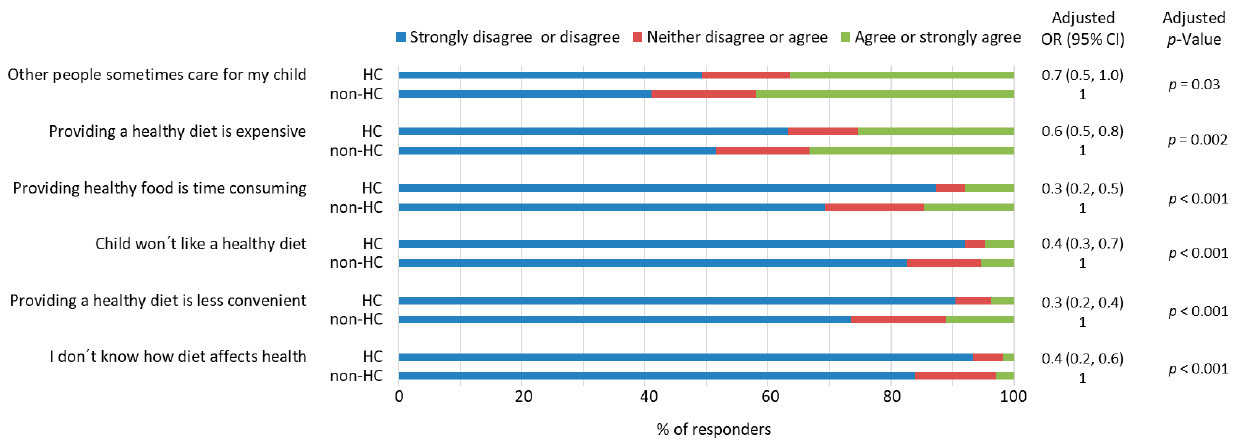
Figure 4. Health-conscious (HC) and non-health-conscious (non-HC) parents´ views on the challenges regarding their ability to feed their child so that her/his lifelong risk of developing disease would be reduced. Associations between the parents’ views and parental health consciousness were examined by ordinal logistic regression analyses after adjustment for the parents’ gender, education, and whether the parent had a degree in a field of health or nutrition. Missing data n = 35–38 depending on the question. OR = odds ratio, CI = confidence interval.